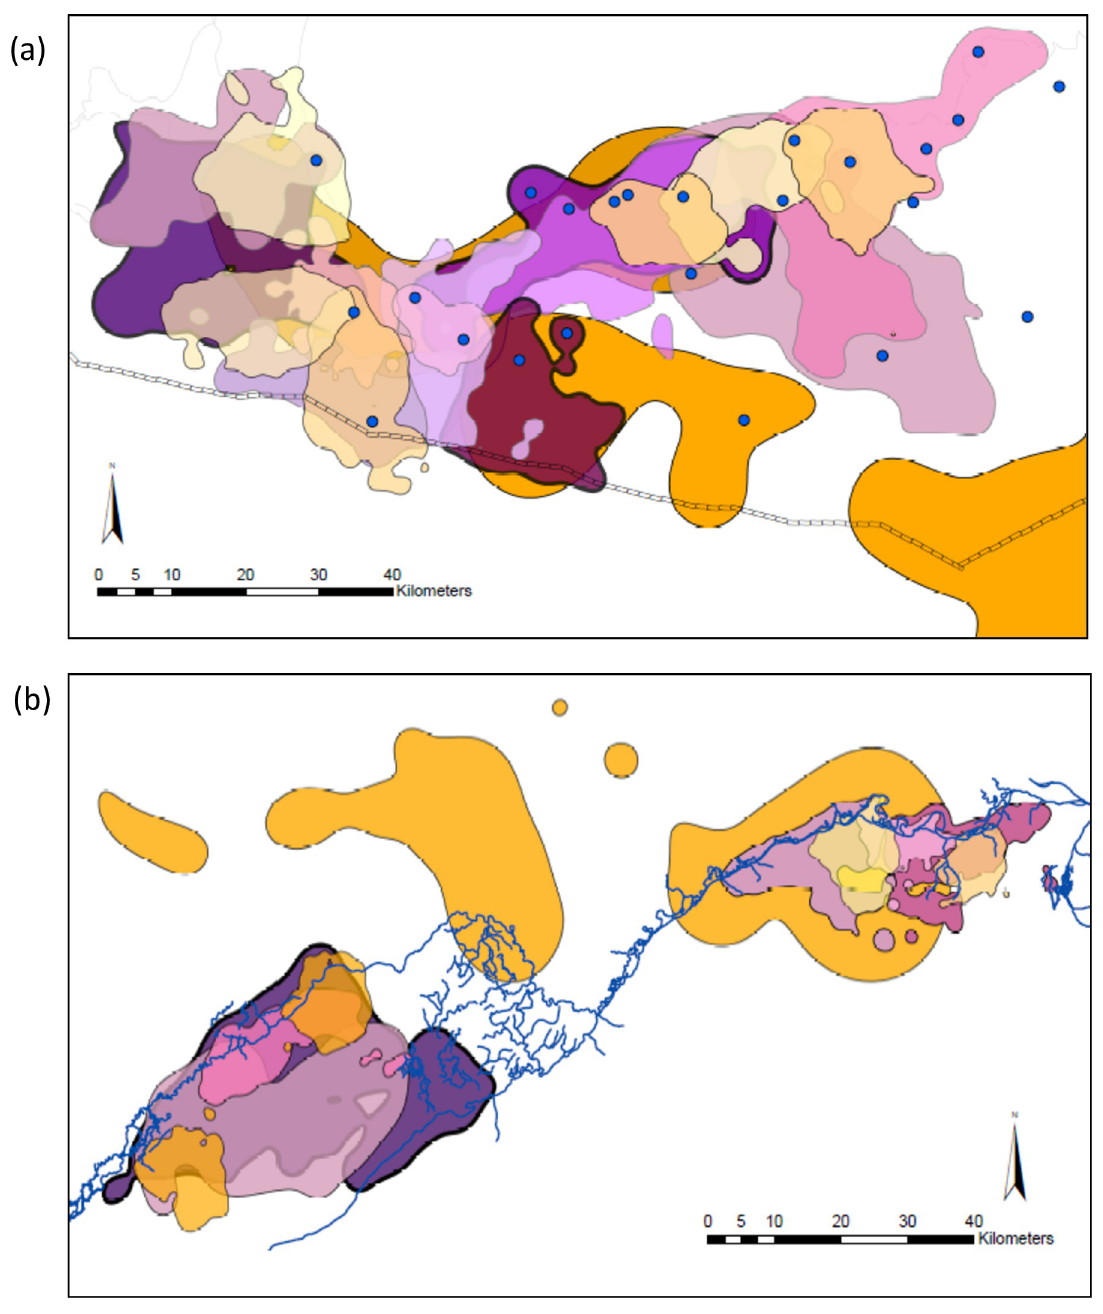
Fig 4. Overlapping ranges within study areas as represented by 95% kernel contours. Polygons of dark purple shades with black outlines = male lion ranges. Polygons of lighter purple/pink shades with grey outlines = female lion ranges. Polygons of orange/yellow shades = spotted hyena ranges. Overlapping polygons are set to 20% opacity for easier visualization. (a) Etosha site with the pan to the north and the park’s fence along the southern boundary. Blue dots represent permanent water points. (b) Chobe/Linyanti site with the river separating Botswana to the south and Namibia to the north. The river is indicated by blue